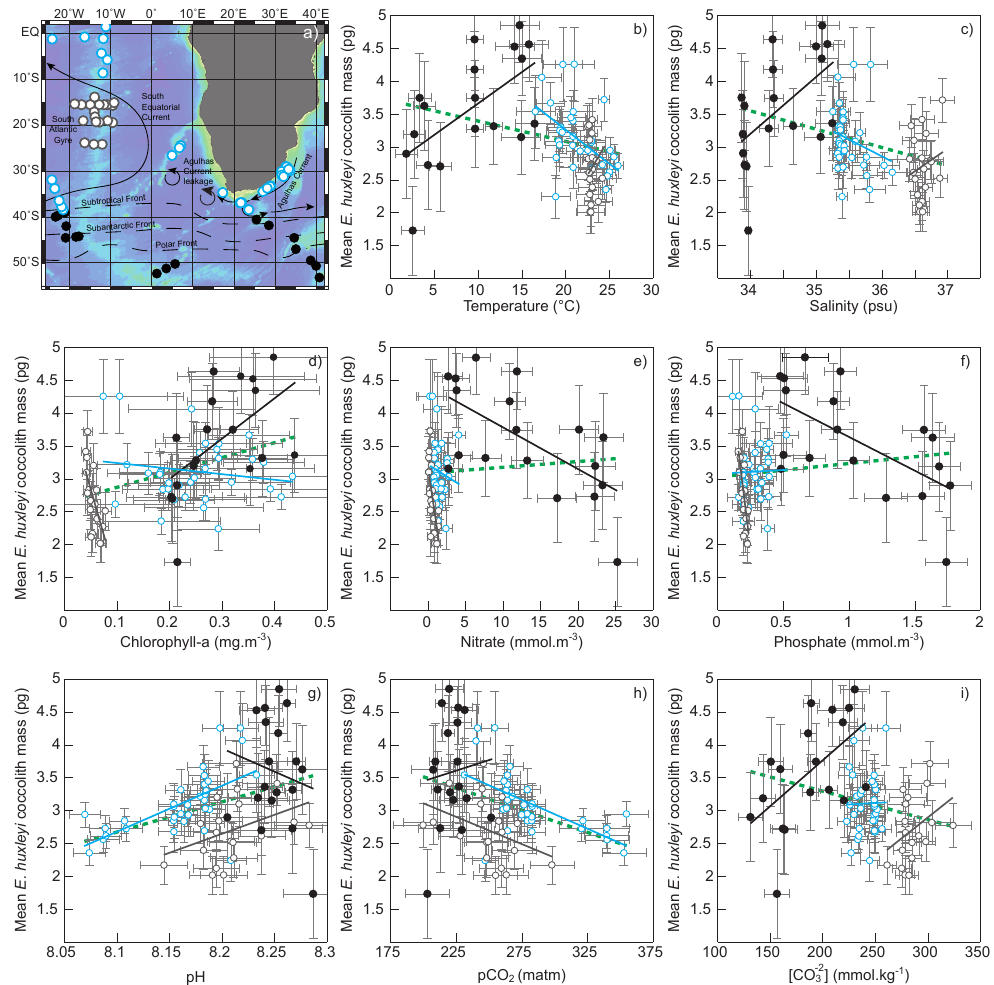
Fig. 3. (a) Distribution map of the samples according to the results of the cluster analysis performed of the environmental parameters (cluster #1 blue circles, cluster #2 open circles and cluster #3 filled black circles). For more details concerning the cluster analysis, see Fig. S2 of the Supplement. (b) – (i) Relations between the mass of E. huxleyi coccoliths and the environmental parameters for the three clusters (the symbols are the same as in (a) ): (b) temperature, (c) salinity, (d) chlorophyll a , (e) nitrate, (f) phosphate, (g) pH, (h) p CO 2 and (i) [CO 2 − The error bars give the 1 σ standard deviation calculated for each cluster. The blue, grey and black lines show the linear regression between the average mass of E. huxleyi coccoliths and the considered environmental parameters for clusters #1, #2 and #3. The green dotted line shows the linear regression between the mass of E. huxleyi coccoliths and the considered environmental parameters for the entire data set (for the r values refer to Table